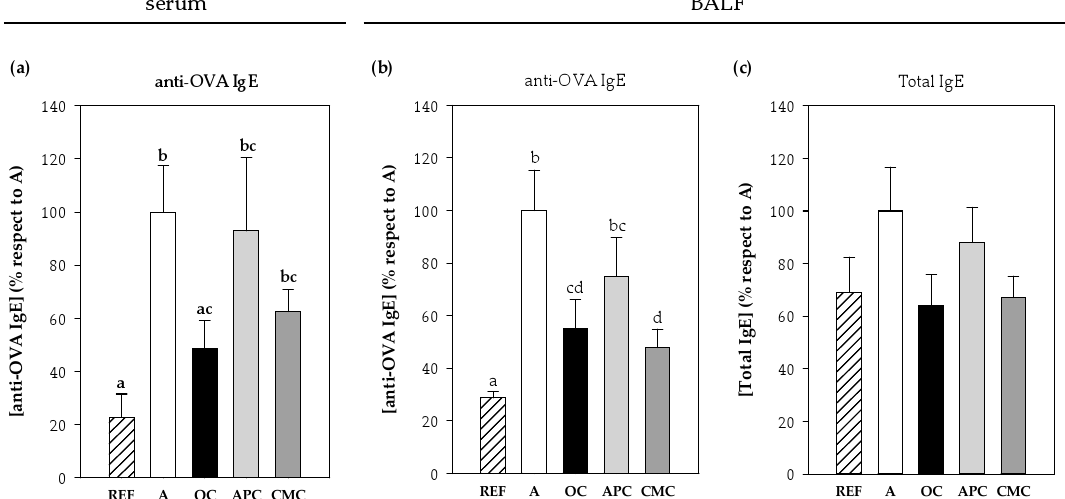
Figure 7. Anti-OVA IgE concentration in serum ( a ) and BALF ( b ) and total IgE content in BALF ( c ) obtained 24 h after the intranasal challenge. REF: healthy animals fed standard diet; A: asthmatic animals fed standard diet; OC: asthmatic animals fed with ordinary cocoa-enriched diet; APC: asthmatic animals fed with “Amazonas Peru” cocoa-enriched diet; CMC: asthmatic animals fed with “Criollo de Montaña” cocoa-enriched diet. Results are shown as mean ± standard error ( N = 9). Values not sharing letters denote significant differences between groups ( p < 0.01), while values sharing the same letter did not differ.